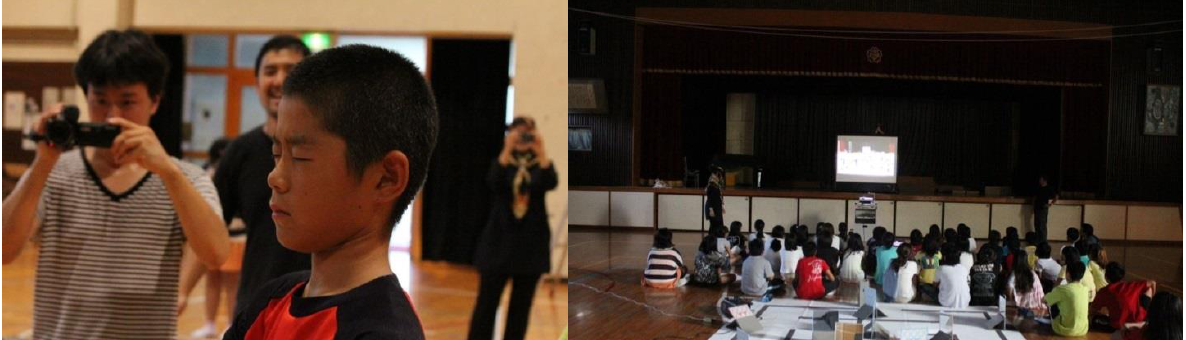
Figure 1 Real Time